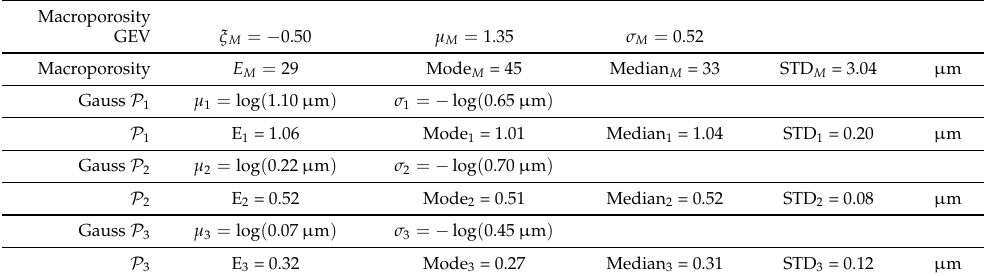
Table A1. A summary of the mean, mode, and median pore diameters for the four individual distributions in Figure 4.